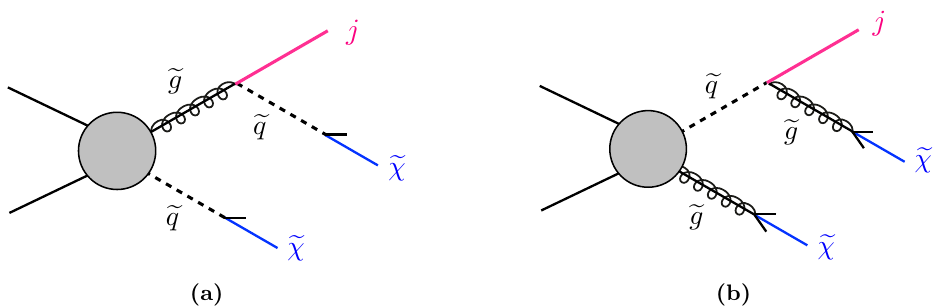
Figure 7 . Monojet signature from gluino-squark associated productions, where the lighter of gluino and squark is only slightly heavier than the LSP neutralino. (a) m ˜ g > m ˜ q m ˜ q > m ˜ g m ˜ χ 0 ’ 1